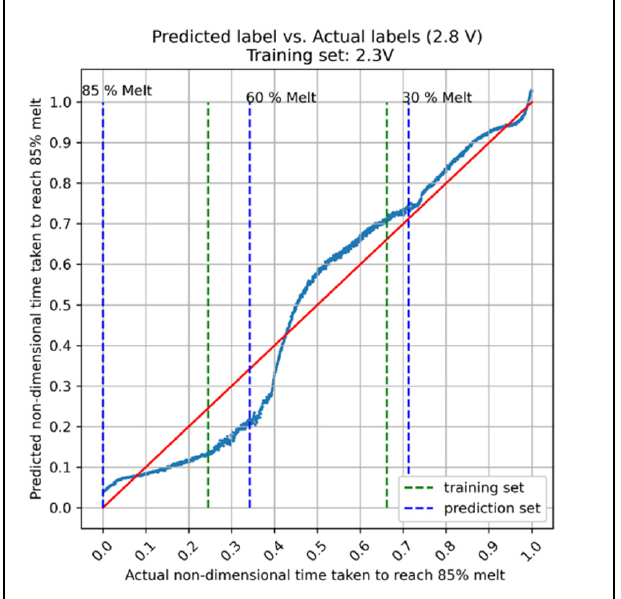
Figure 12. Scatter plot comparing the ANN predictions with experimental data for test data set of